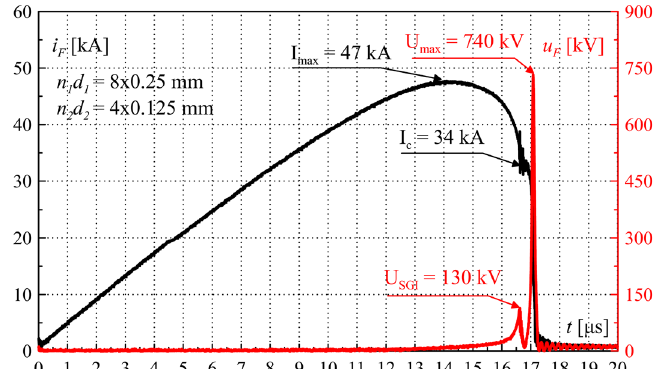
Figure 14. TSFF current i F and voltage u F waveforms during operation—laboratory test results. Characteristic values are marked in the figure.